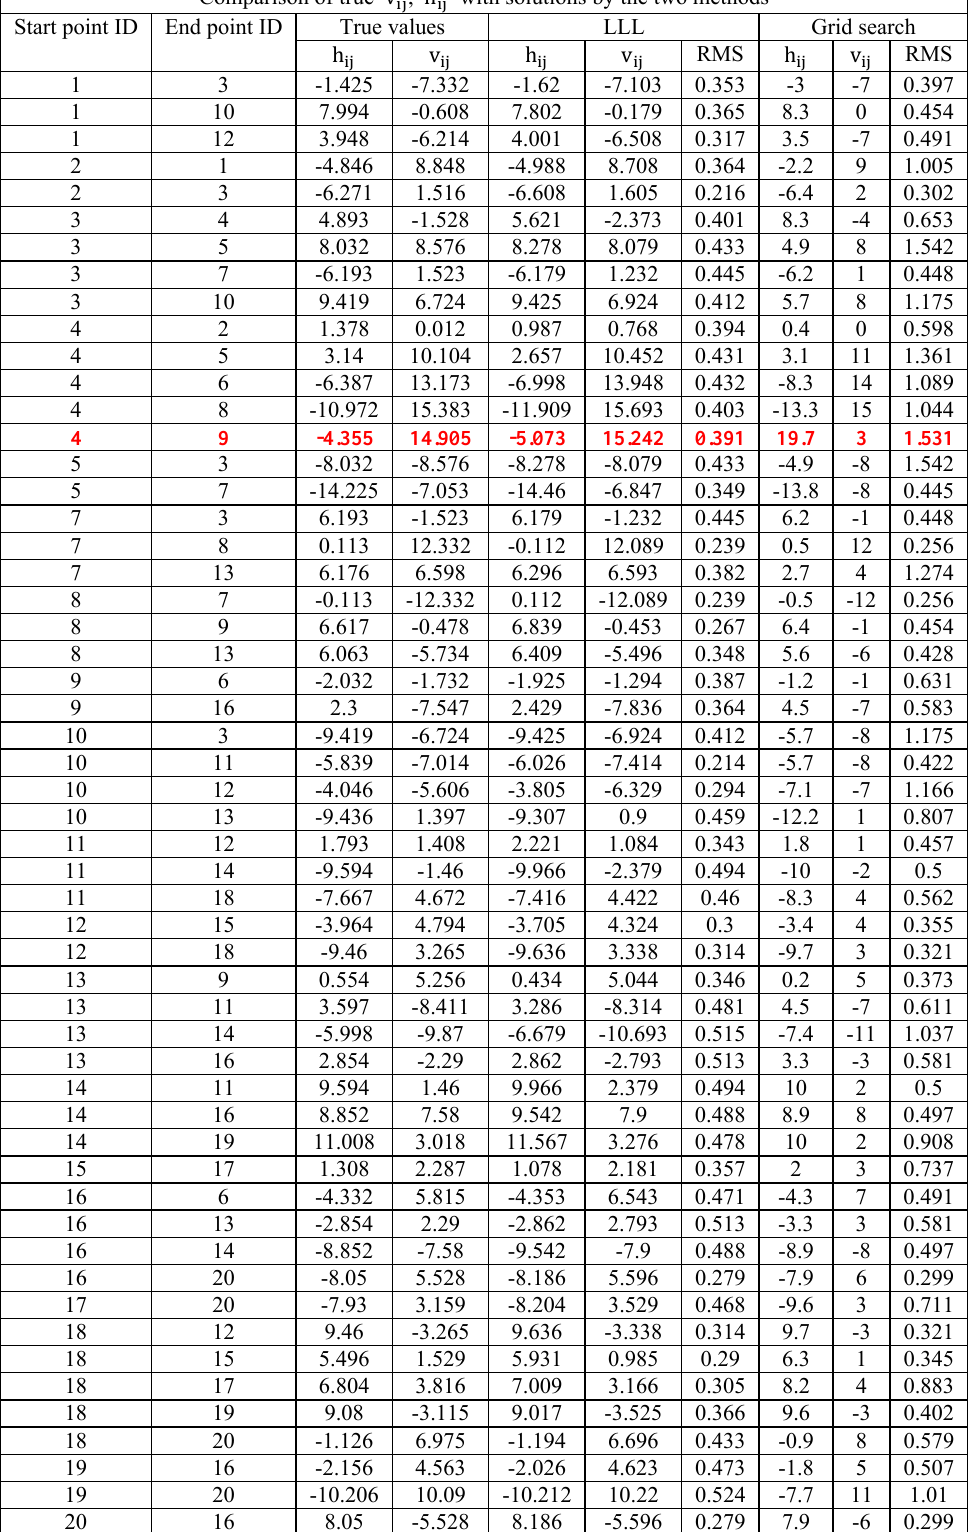
Table 2. Comparison of true relative elevation errors and sediment rate differences of PSPs with